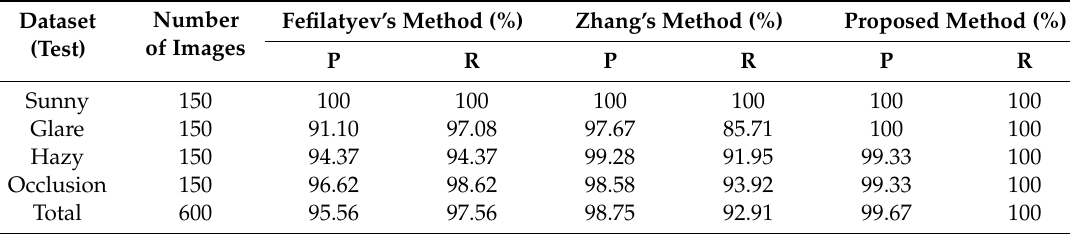
Table 6. Precision and recall scores for the three methods.